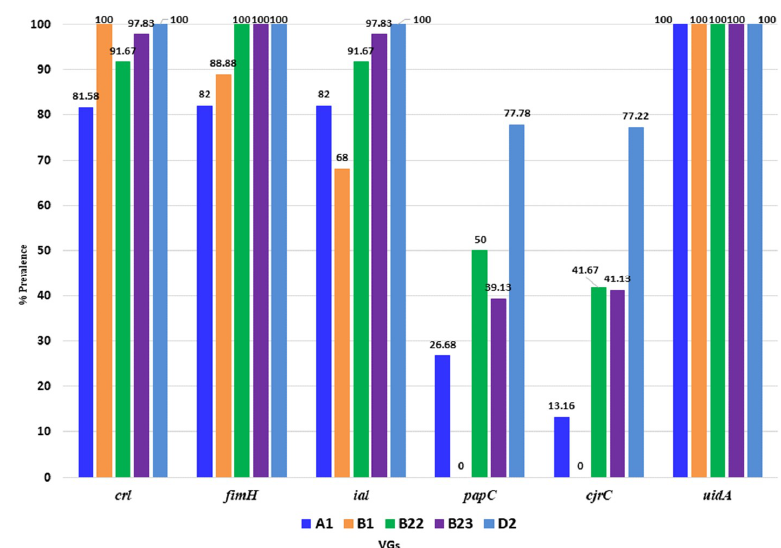
Figure 5. Prevalence of the three pathogenic genes among the APEC phylotypes. Here x -axis represents the phylotypes, and the y -axis denotes the prevalence (%) of the genes among the E. coli isolates. For phylotype A1: First column represents the crl gene; while second for fim H; third for ial ; fourth for pap C, fifth for cjr C, and sixth for uid A gene. This serial is true for all the other phylotypes. Microorganisms 2020 , 8 , x